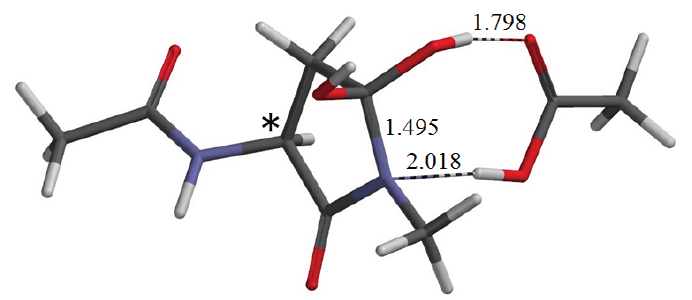
Figure 6. The geometry of I•AA-1 ( φ = − 167°, ψ = − 138°, χ 1 = 117°), which is the intermediate complex directly connected to TS-1. Selected interatomic distances are shown in Å. The asterisk (*) indicates the α